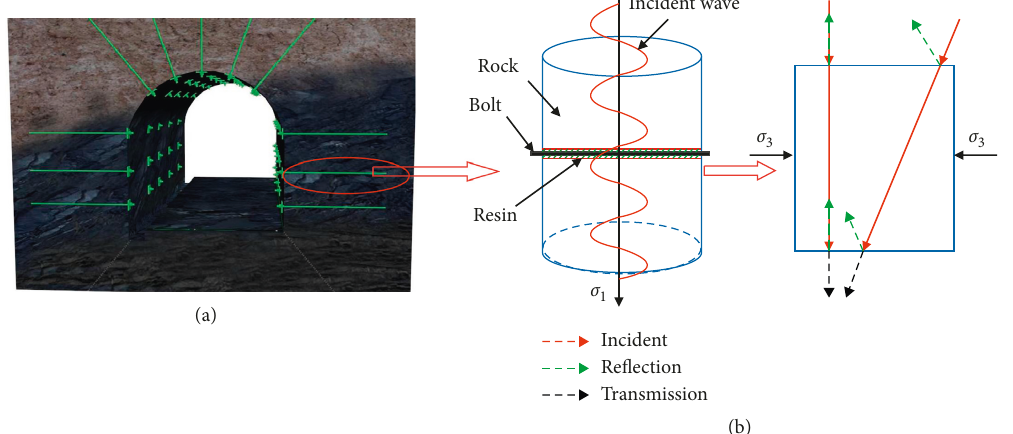
Figure 12: Graph of wave propagates in reinforced roadway. (a) Rockbolt reinforced roadway. (b) Waves propagate in interior of reinforced